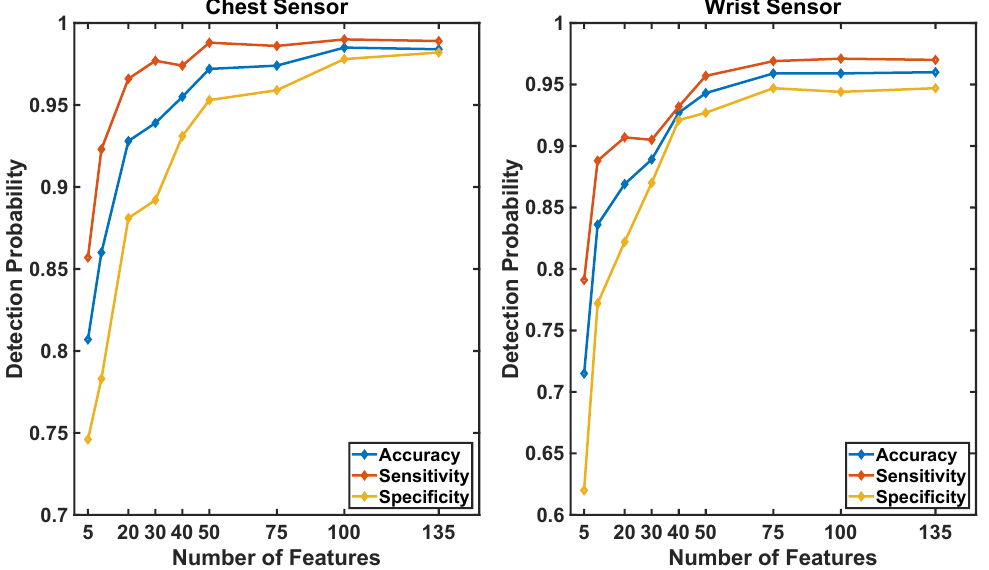
Figure 7. Algorithm performance as a function of the number of data features used as input to the proposed machine learning-based